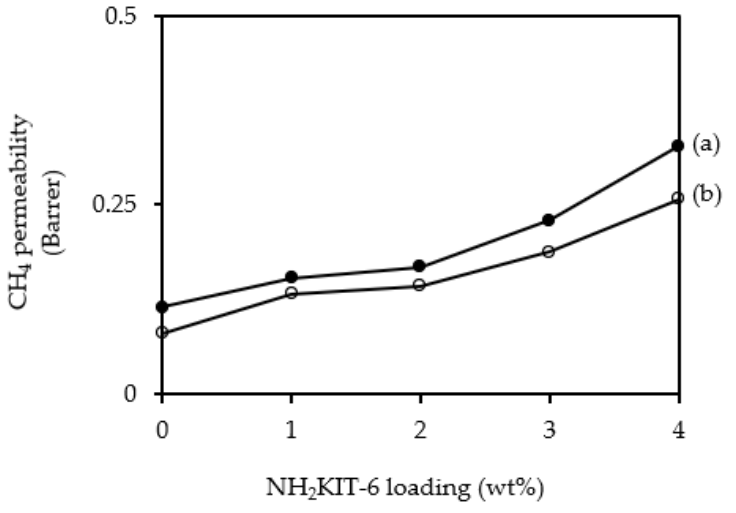
Figure 9. CH 4 gas permeability of the membranes incorporated with different NH 2 KIT-6 loadings at pressure differences of ( a ) 5 bar and ( b ) 7 bar.